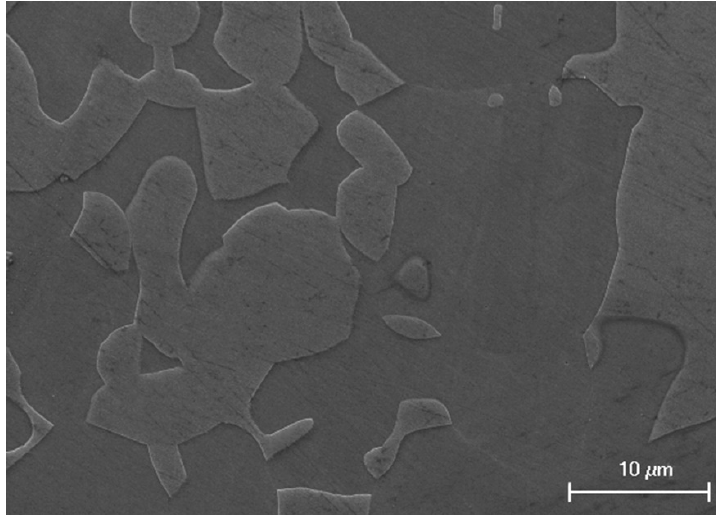
Figure 1. Microstructure of DSS 2205, solution-annealed at 1050 °C for 1 h, showing ferrite (dark) and austenite (bright) phases.